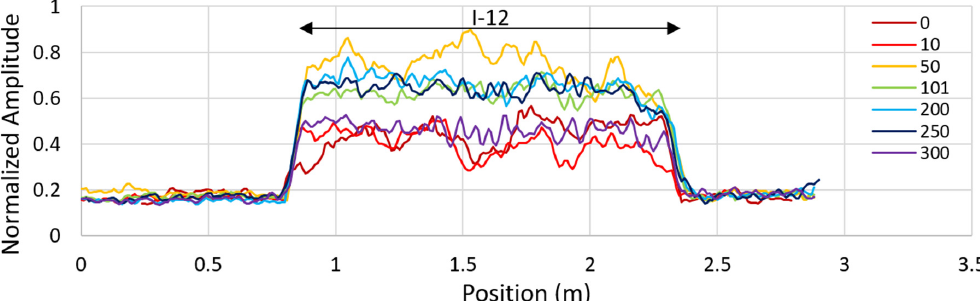
Figure A5. 2.6 GHz normalized RW amplitudes on sand (I-11) in the longitudinal direction vs. K loadings.